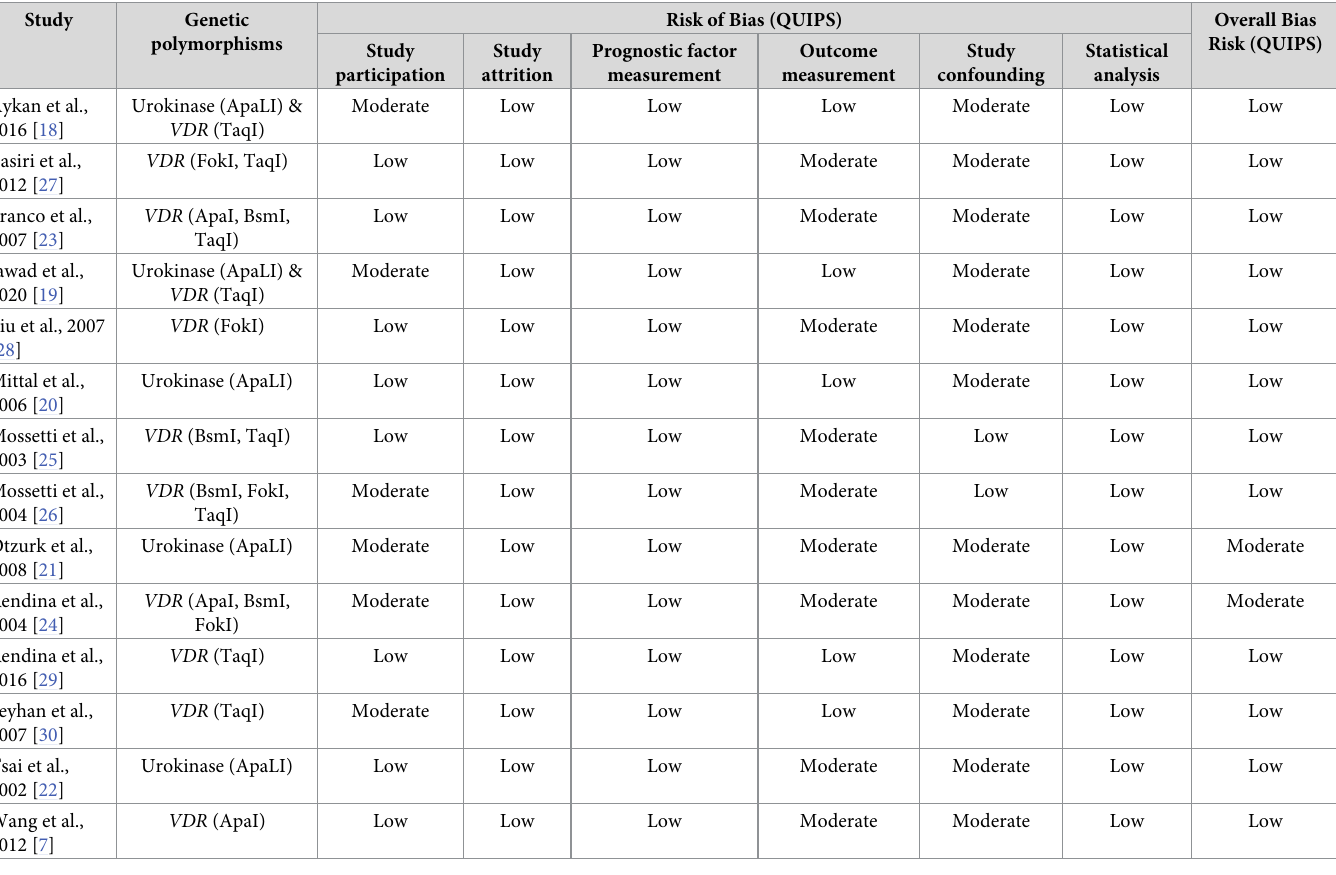
models. Table 5 showed the association in the recessive model was still significant when restriction of larger studies was applied (CC vs. CT/TT: OR 0.40, P < 0.01), suggesting the lack of publication bias. A significant protective effect of this polymorphism was also apparent Table 3. Risk of bias from individual studies included in the